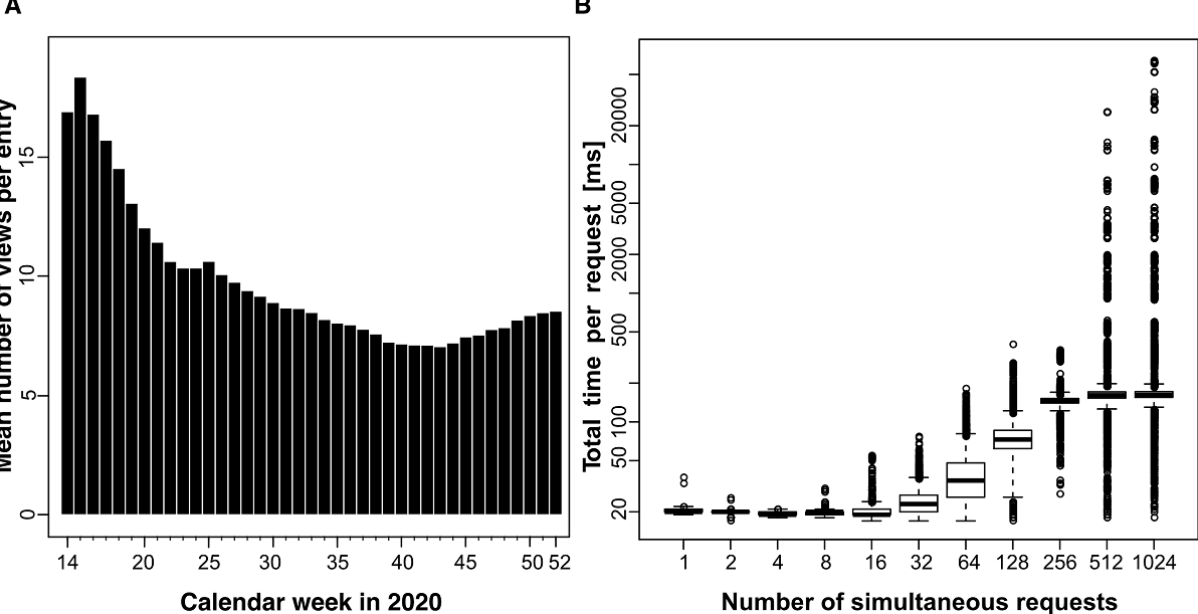
Figure 4. Requests to the CTest server. (A) Since its introduction into the routine at the University Hospital Ulm (Germany) in week 14 (2020), a mean of about 10 (SD 2.8) views per test entry was recorded. The plot shows the mean number of views per entry per calendar week in 2020 as bars. (B) The server can respond within 200 ms to >80% of requests when responding to up to 1024 simultaneous requests. In this simulation, requests were made using a single machine and a single network